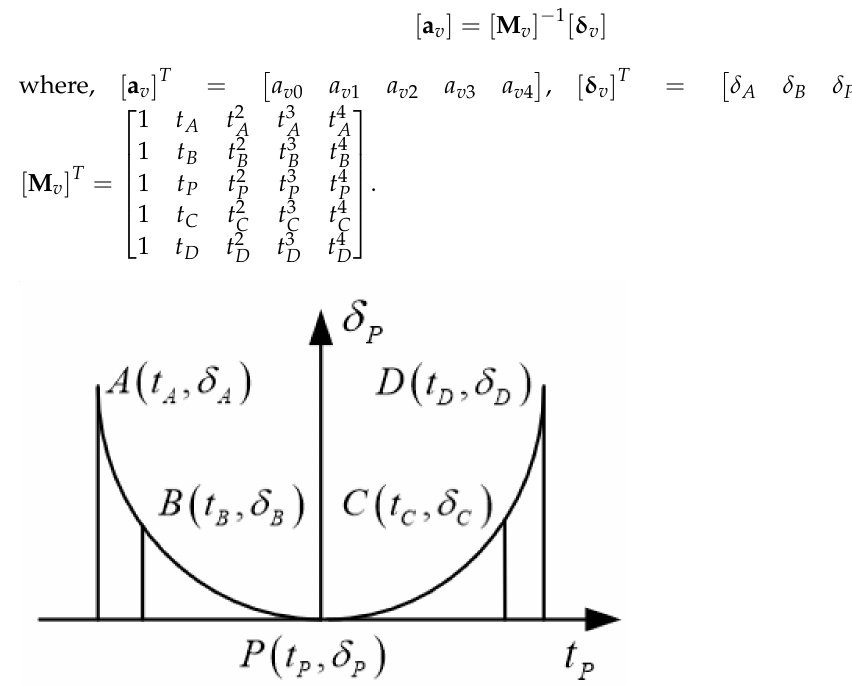
Figure 6. Modification amount of each point in the direction of tooth surface contact